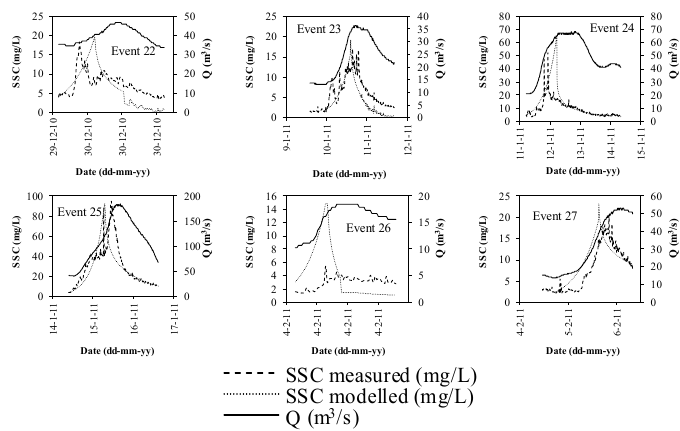
Figure 9. Suspended sediment concentration (SSC) measured and modeled with the Garcia et al. [2,3] modified model.